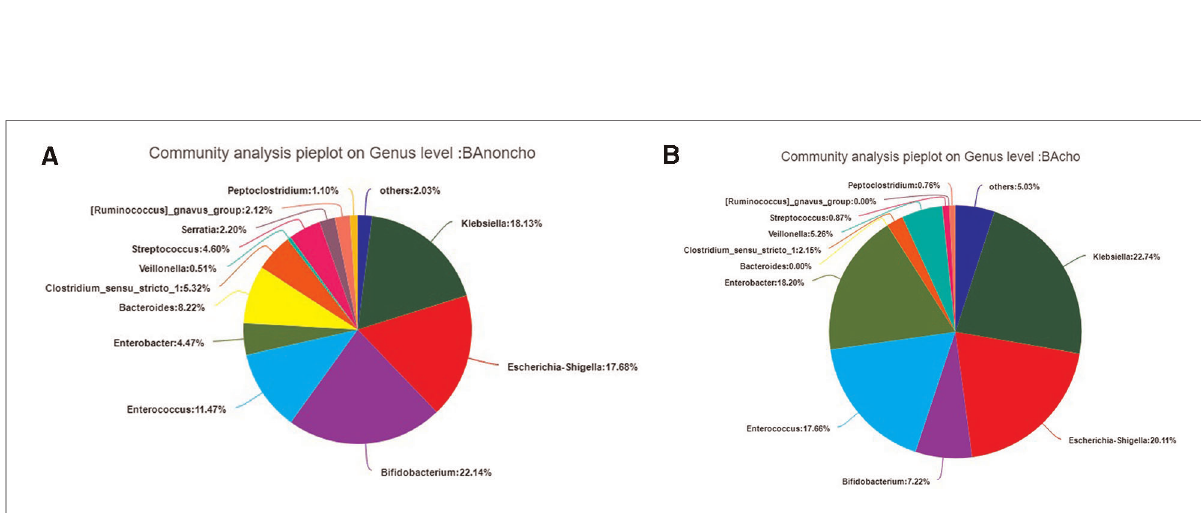
FIGURE 3 ( A ) The distribution of gut microbiota on genus level in BAnoncho. Bi fi dobacterium accounted for 22.14%. Klebsiella occupied 18.13%. Escherichia- shigella accounted for 17.68%. ( B ) The distribution of gut microbiota on genus level in BAcho. Klebsiella accounted for 22.74%. Escherichia-Shigella occupied 18.13%. Enterococcus accounted for